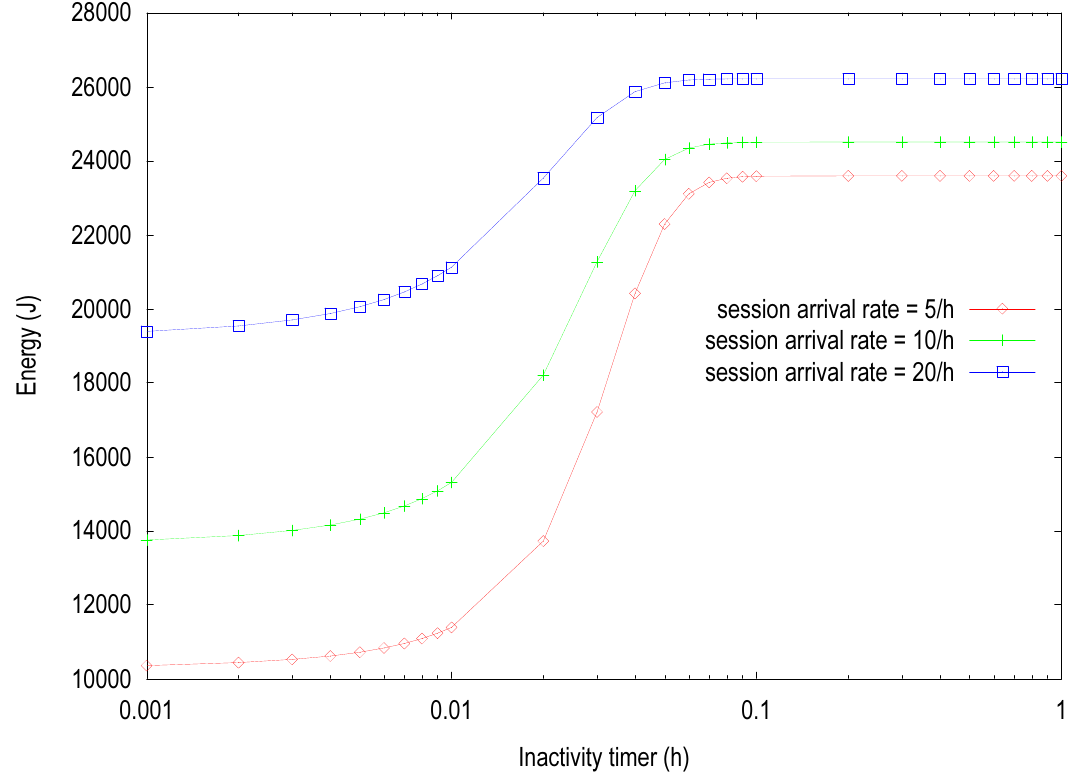
Figure 4. Energy consumption by varying the session arrival rate (small values of T and T ). E W